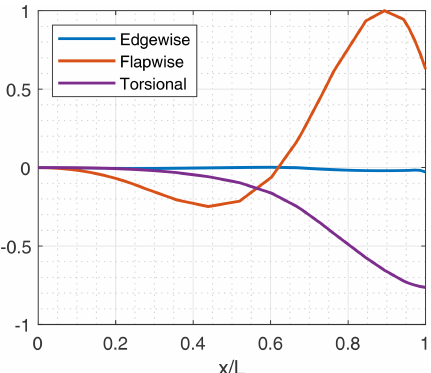
Figure 5. Illustration of first classical flutter mode for the SNL100- 03